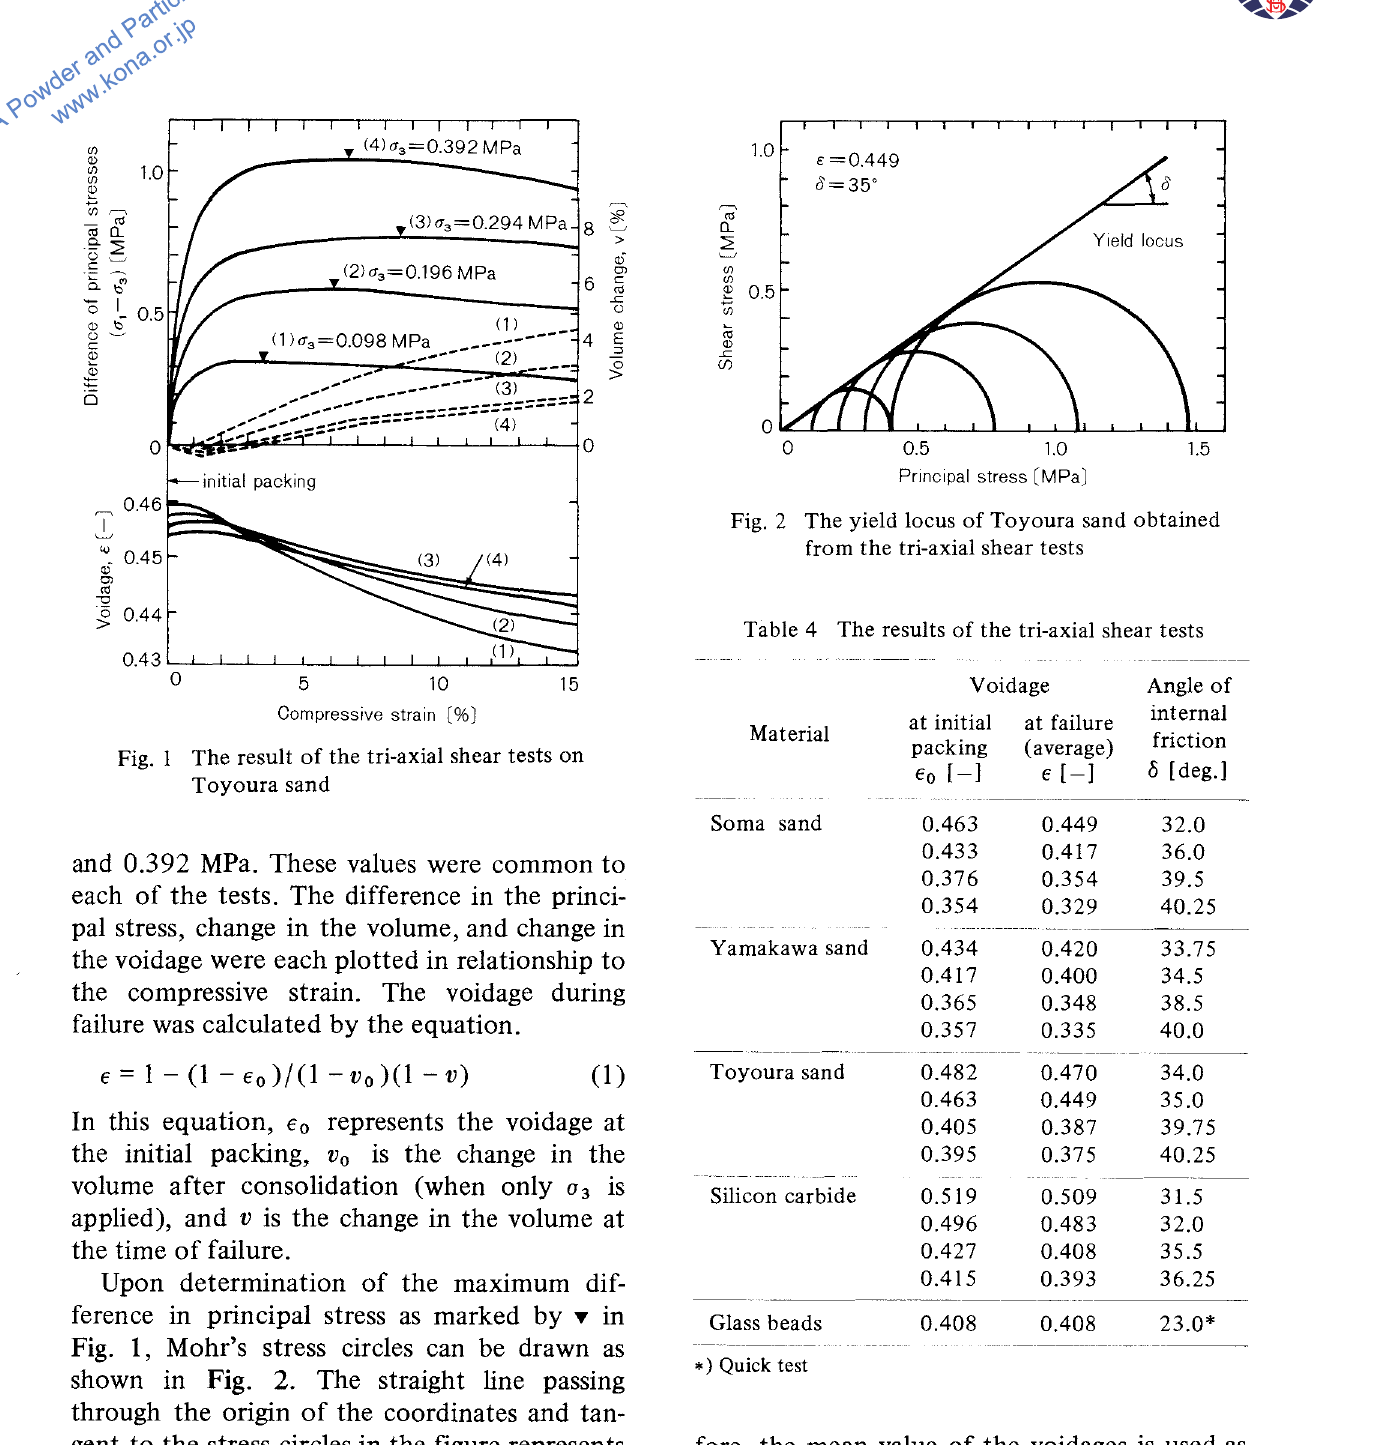
Fig. 2 The yield locus of Toyoura sand obtained from the tri-axial shear tests